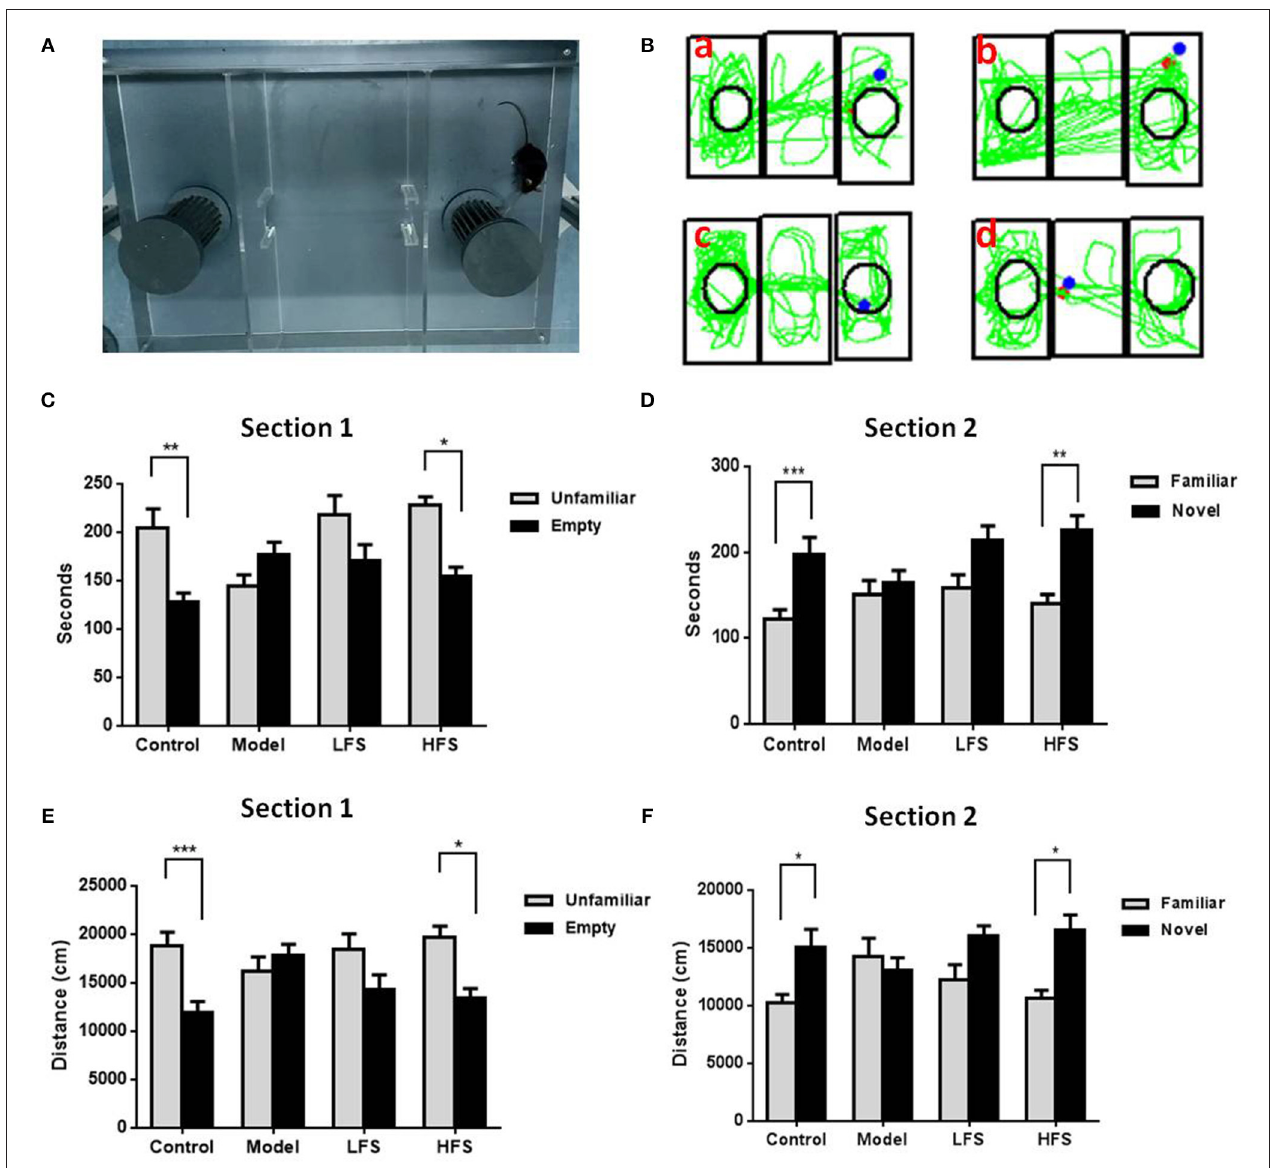
FIGURE 3 | Social behavior is impaired by cuprizone and rescued by DMS. Results of the social interaction test are shown in (A–D) . (A) Photo of the three-chamber apparatus used for the social interaction test. (B) Representative movement traces of (a) control mice, (b) model group, (c) LFS group, and (d) HFS group. (C,D) Histograms showing time spent in each side chamber in trials 1 and 2. (E,F) Histograms showing the distance traveled in proximity to the wire cages containing stranger mice or the empty cage in trial 1. Values are expressed as mean ± SEM ( n = 12–15). * P < 0.05, ** P < 0.01, *** P <